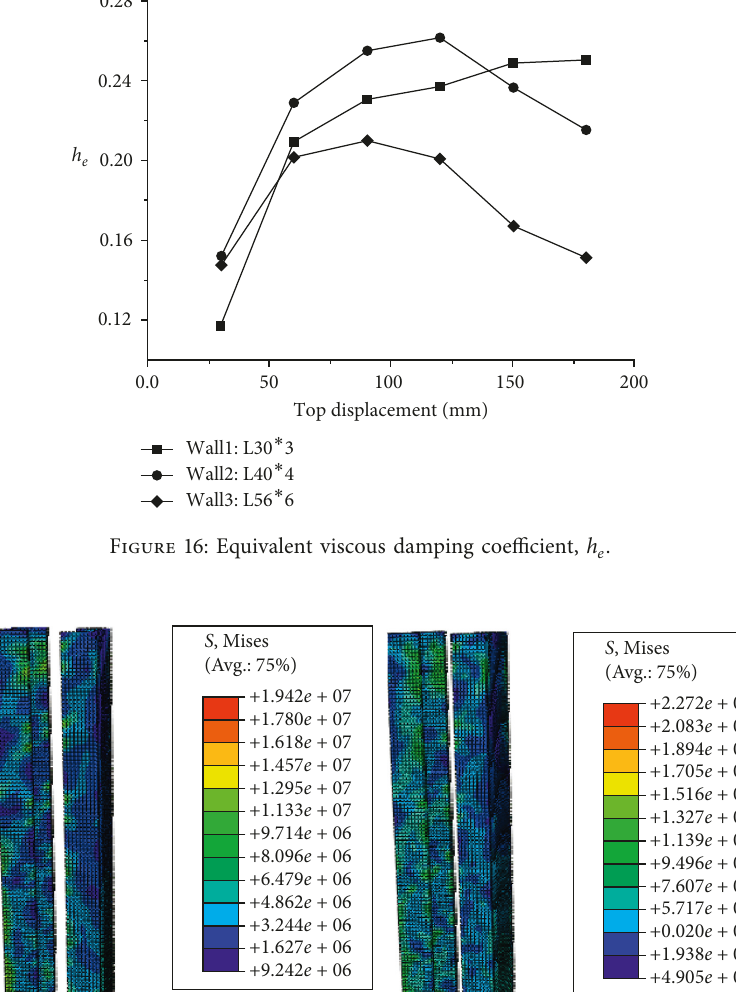
Figure 17: Deformation and Mises stress (unit: N/m 2 ) of the shear walls: (a) specimen WALL1; (b) specimen WALL2; (c) specimen